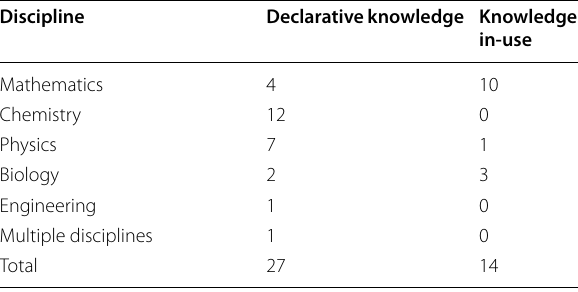
1 Four theorizing papers from mathematics were excluded from these counts: (Delgado-Robolledo et al., 2020; Hauk et al., 2013; Liang, 2019; Nuzzi et al., 2020)